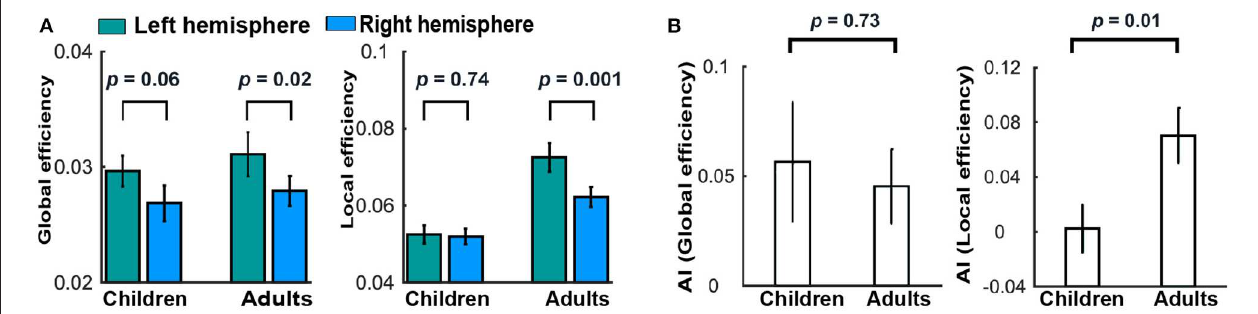
FIGURE 6 | Development of brain asymmetry. (A) Differences between the hemispheres in global and local efficiency for each group. (B) Group differences in the AI of global and local efficiency. These figures were adapted from Cai et al. (2018) under a CC BY-NC-ND 4.0 license.